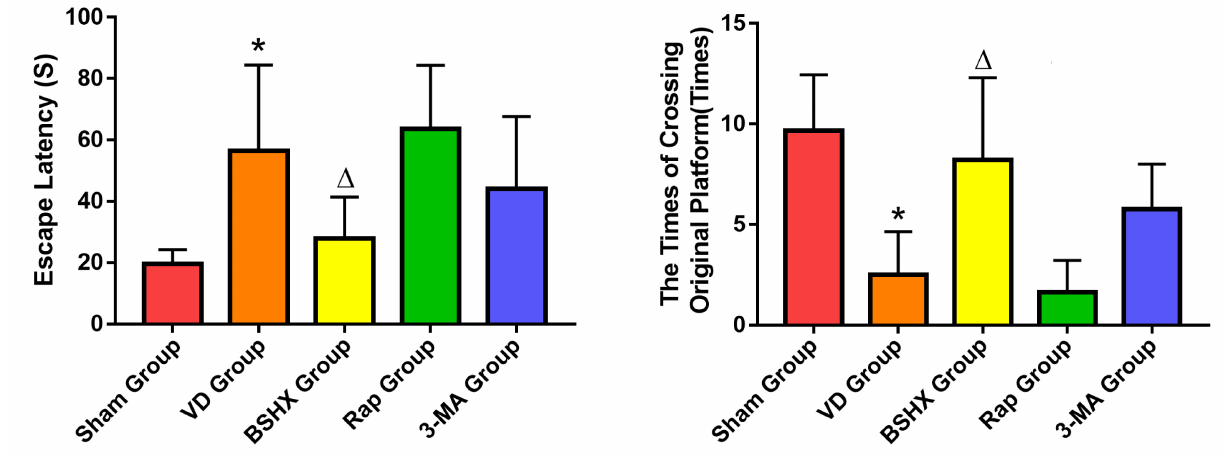
Fig. 6. The comparison of behavioral changes of Morris Water Maze in Rats. (A) The comparison of escape latency in rats. Compared with the Sham group, ∗ p < 0.05; Compared with the VD group, △ p < 0.05. (B) The comparison of the times crossing the original platform in rats. Compared with the Sham group, ∗ p < 0.05; Compared with the VD group, △ p <